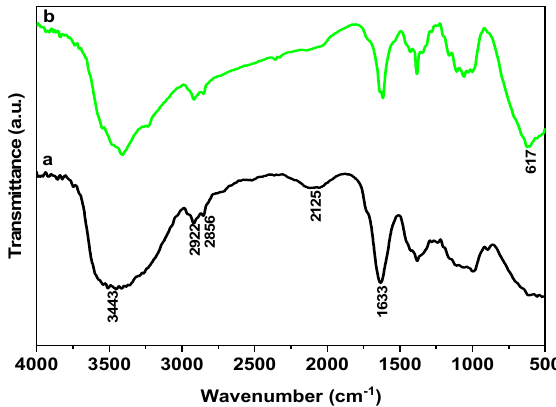
Figure 2. FTIR spectra of flax fiber before ( a ) and after ( b ) impregnation with a solution of titanium hydroxocomplexes.